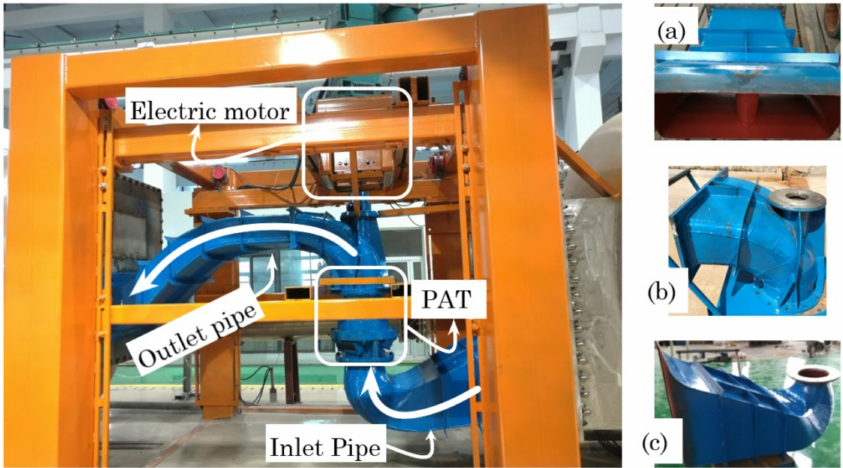
Figure 2. Experimental test rig and components ( a ) outlet pipe, ( b ) shaft zone, and ( c ) inlet pipe.